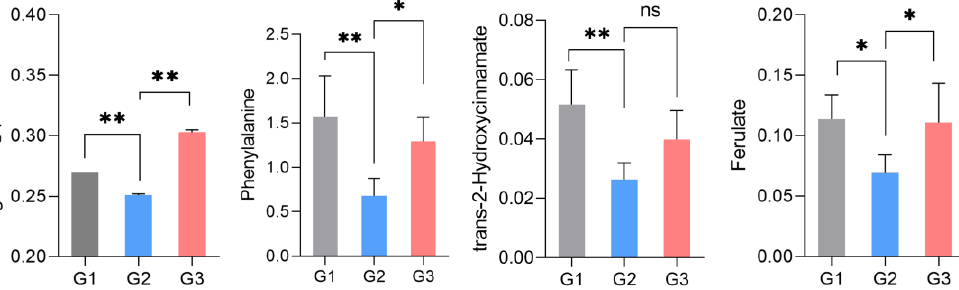
Figure 7. Lignin, phenylalanine, 2-hydroxycinnamate and ferulate expression regulated by LGC. * ( p < 0.05), ** ( p < 0.01), n = 6. ns = no significant